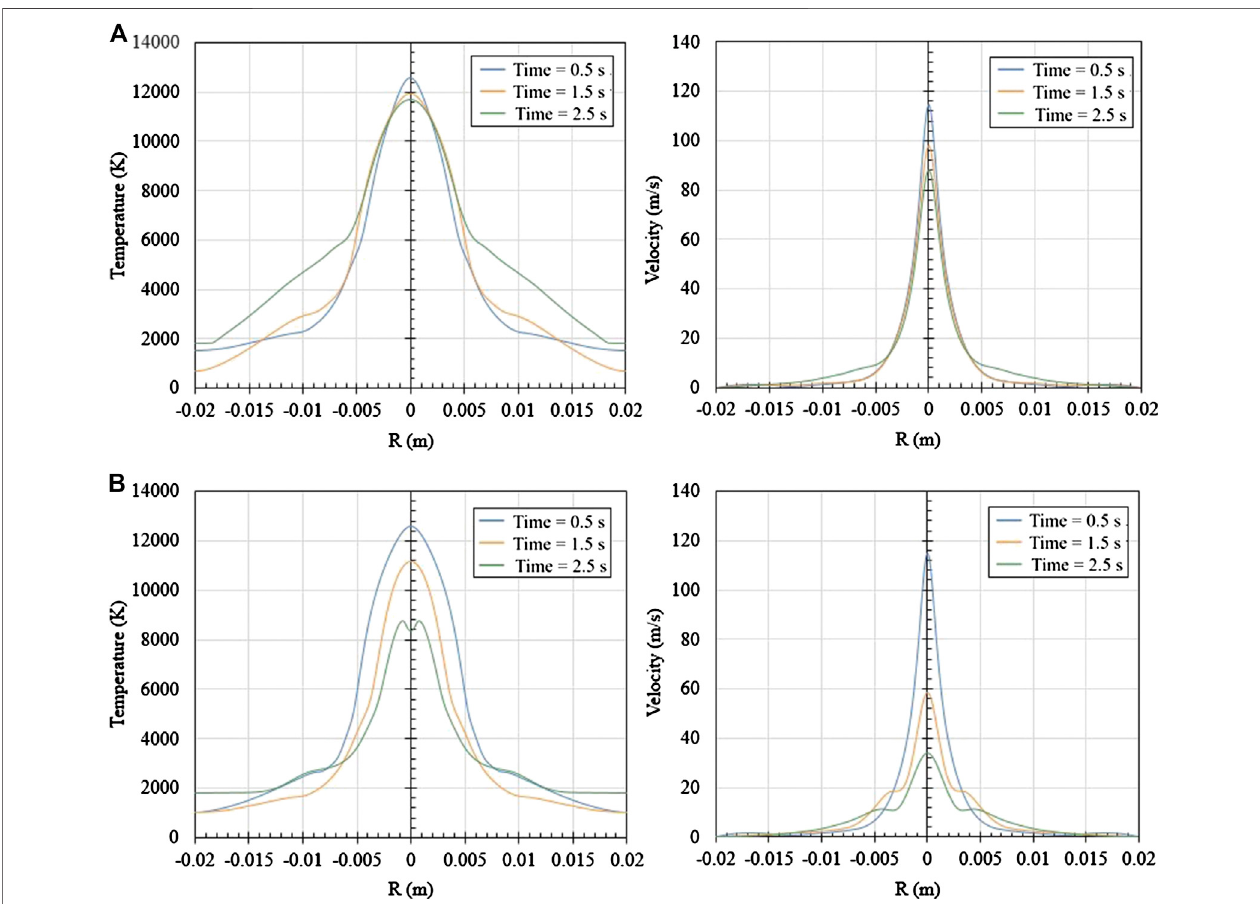
FIGURE11|(A) Axialtemperatureandvelocity distributionat0.0005 mabovetheingottopsurface withthedynamicmovingelectrode. (B) Axial temperature and velocity distribution at 0.0005 m above the ingot top surface without the dynamic moving electrode.